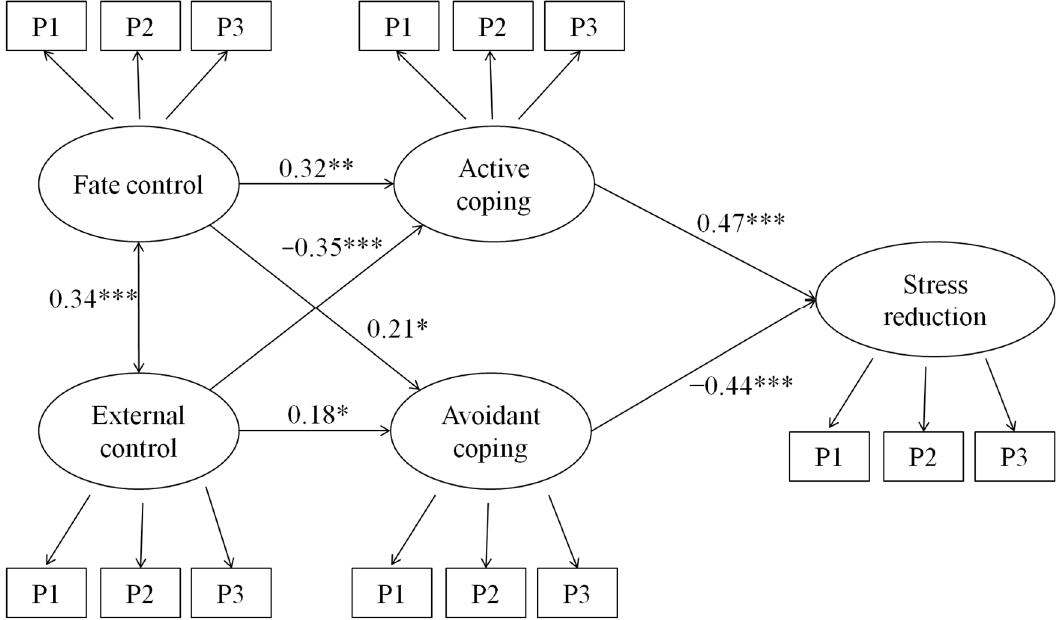
Figure 2. Structural equation model with standardized coefficients in Study 2. * p < 0.05, ** p < 0.01, *** p < 0.001.